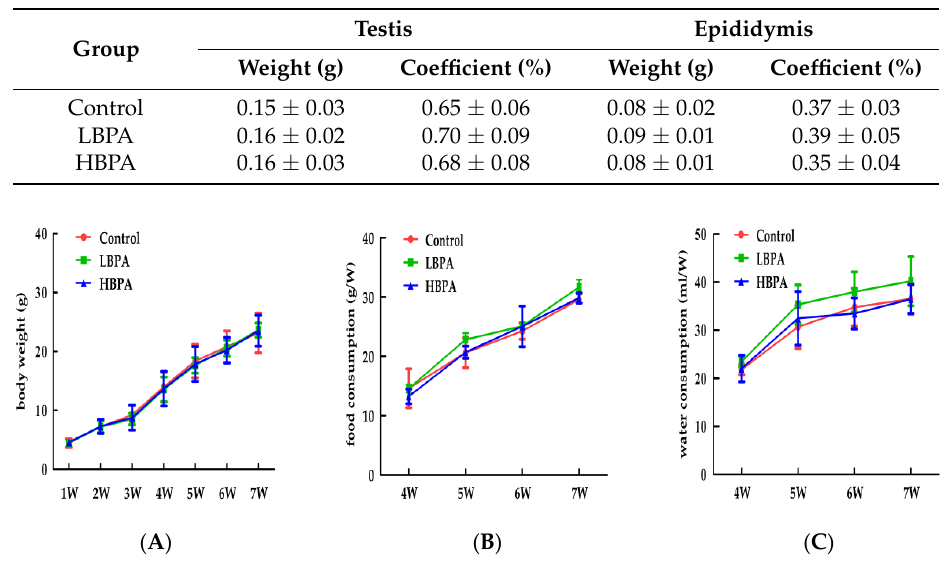
Table 1. Effects of perinatal BPA exposure on the weight and organ coefficient (%) of testis and epididymal tissue (g) in male offspring. Pregnant mice ( n = 7/group) were exposed to ethanol or BPA in water at levels of 0.2 µ g/mL (LBPA) or 2 µ g/mL (HBPA) from gestational day 6 through to the end of lactation. Values represent the mean ± SE ( n = 7, one from each group) and were analyzed by one-way ANOVA.